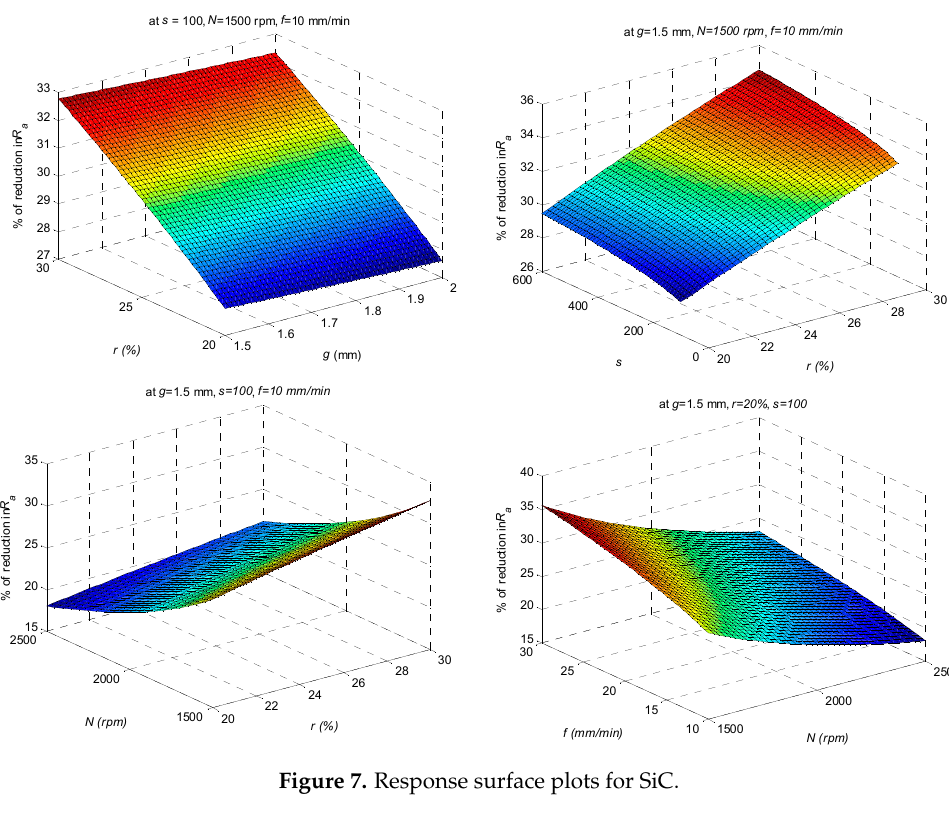
Figure 7. Response surface plots for SiC.